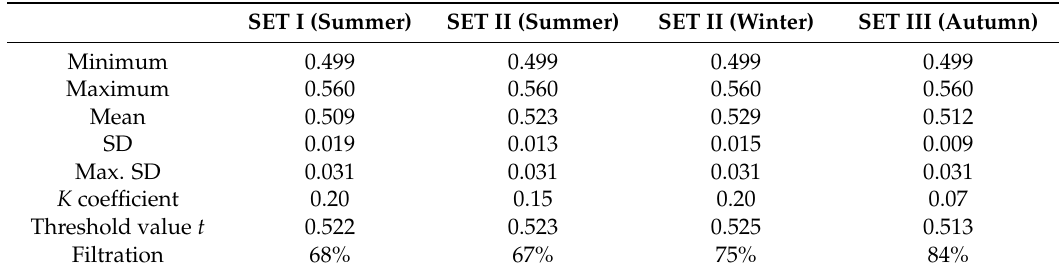
Table 2. Intensity and filtration statistics for chosen lines from all data sets.